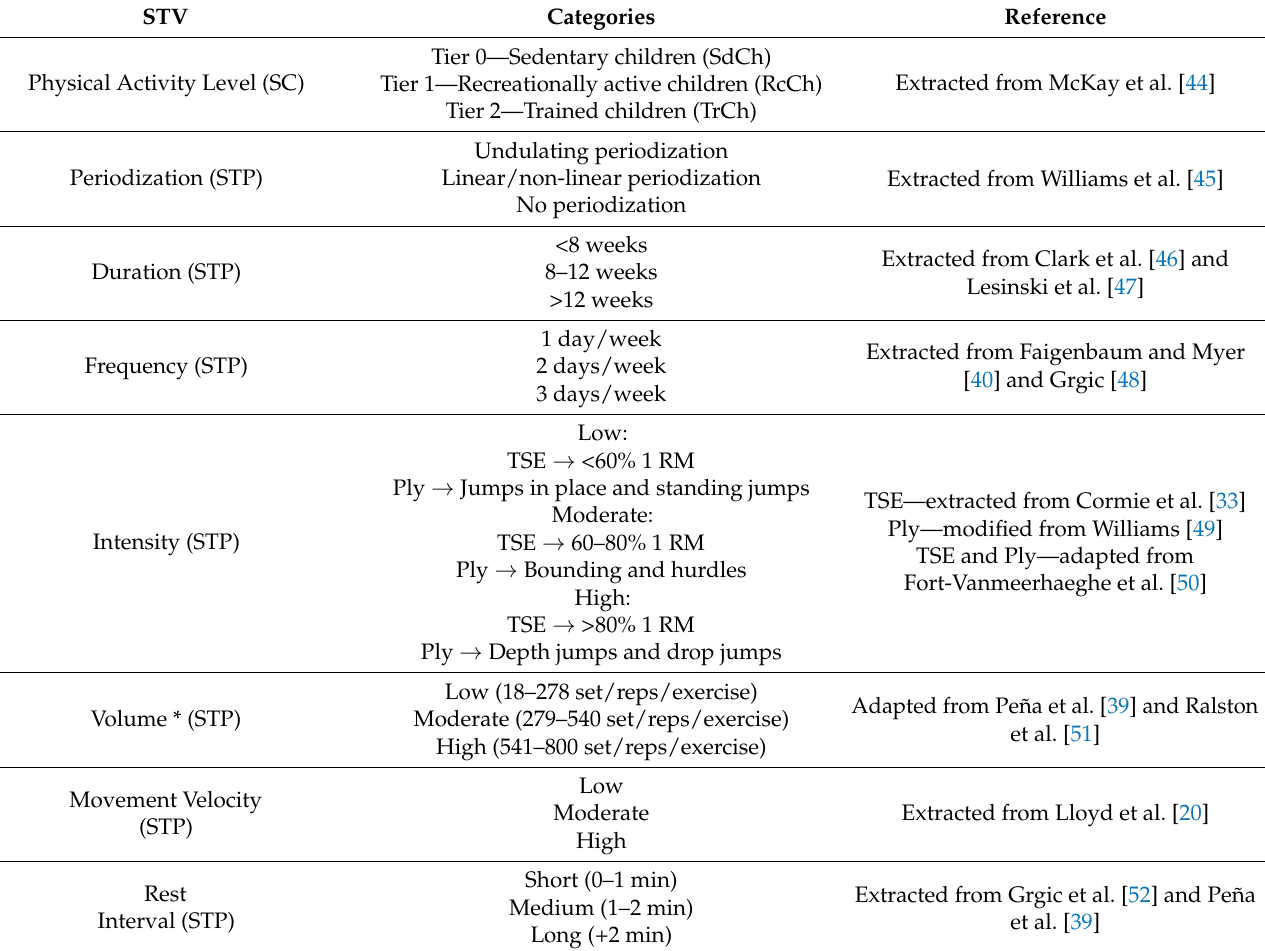
Table 1. Study strength training variables (STVs) categorized according to scientific evidence in relation to sample characteristics (SCs) and strength training program